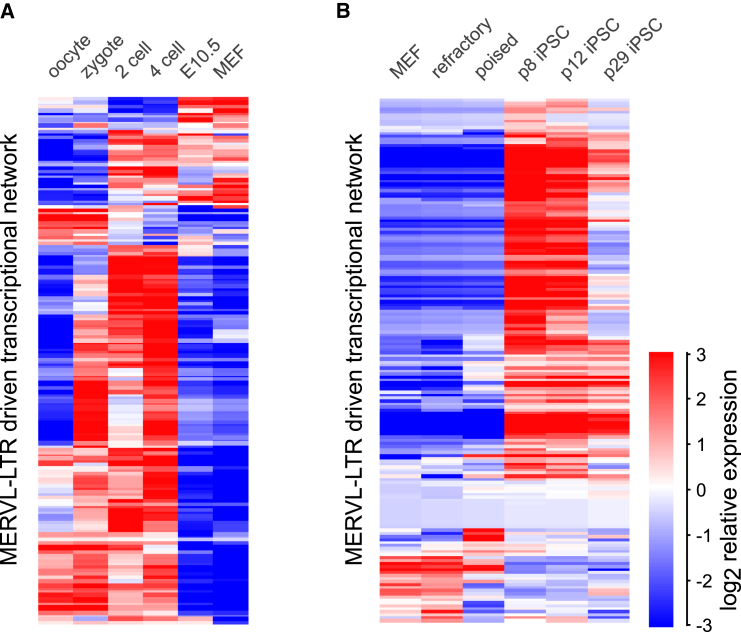
MERVL-LTR-Driven Transcriptional Network Activated upon iPSC Reprogramming(A and B) Heatmap showing relative probe-normalized expression levels of MERVL+ transcriptional network in early embryos (A) and induced pluripotent stem cell reprogramming (B). MEF, mouse embryonic fibroblasts. Refractory (SSEA1-/Thy1+) and poised (SSEA1+/Thy1−) stages correspond to fluorescence-activated cell sorting (FACS)-sorted cells at day 6, where passage 8 (p8; corresponding to day 21), p12 (corresponding to day 29) iPSCs represent intermediate-late stages of reprogramming and p29 (corresponding to day 60) iPSCs are fully reprogrammed. Scale bar depicts log2 relative expression. Data are from Park et al. (2015) (A) and (I.M., unpublished data) (B).See also Figure S2 and Table S4.